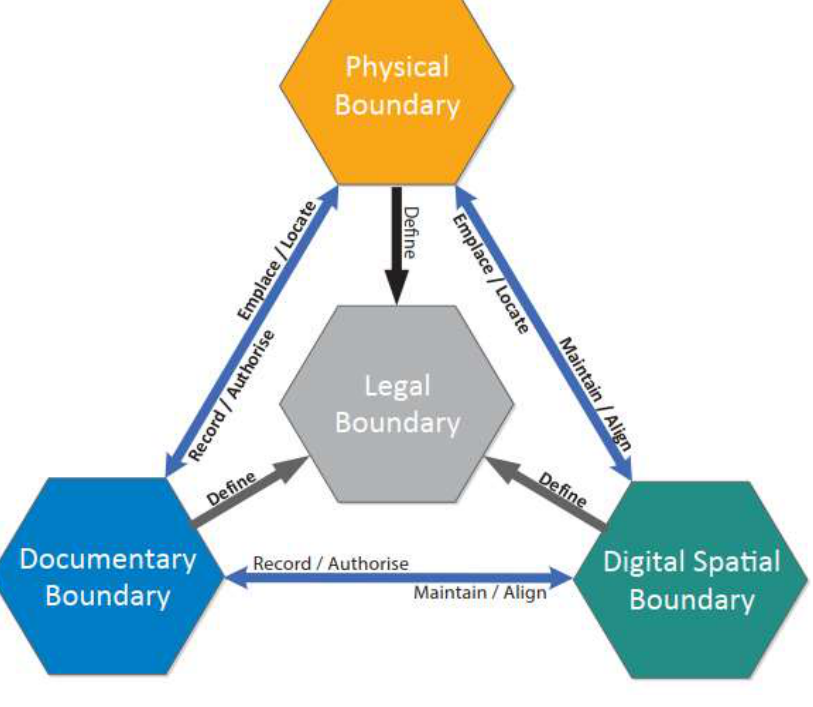
Figure 1. Cadastral Triangular Model (CTM)